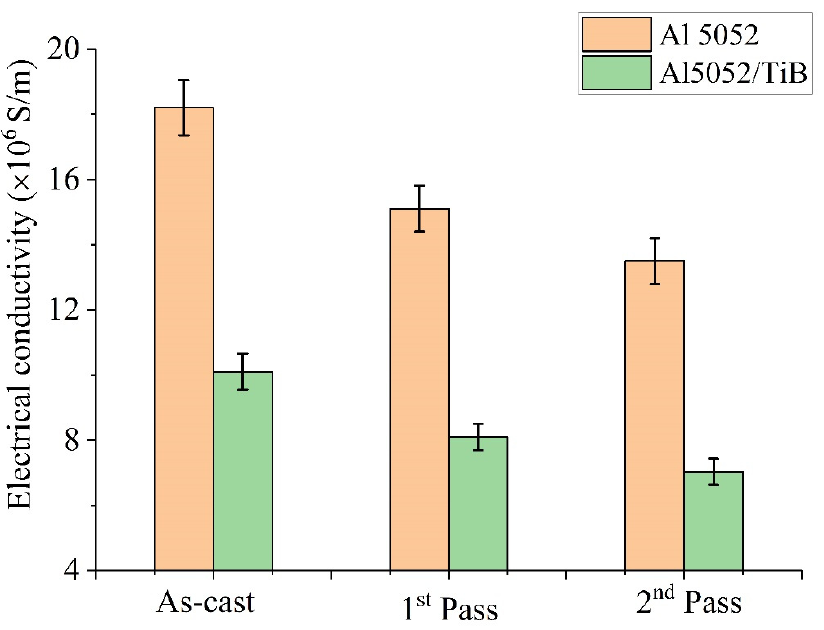
Figure 16. Electrical conductivity of Al 5052 and Al 5052/TiB samples.